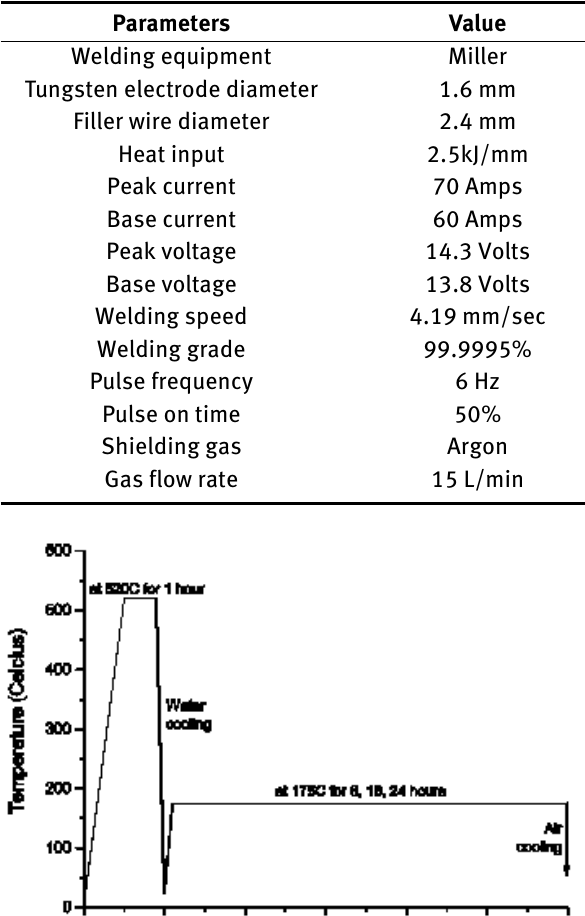
Table 2: The welding parameters used in this investigation.